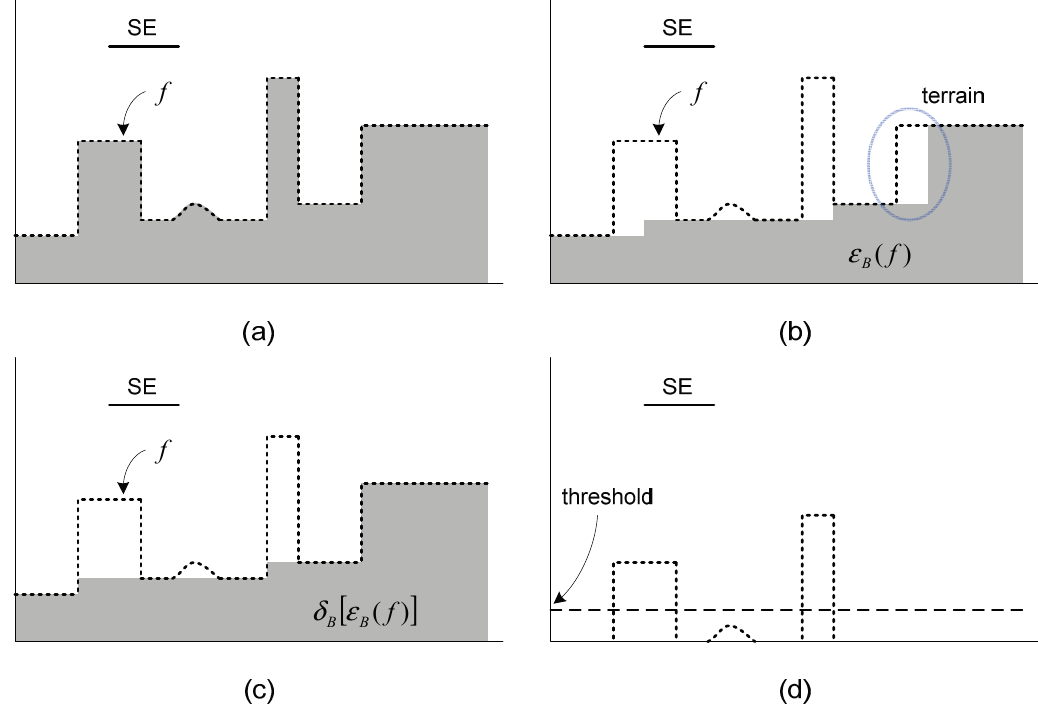
Figure 1. Example of the classic top-hat transformation: ( a ) input set f and SE; ( b ) erosion result; ( c ) result of dilation after erosion; ( d ) extracted